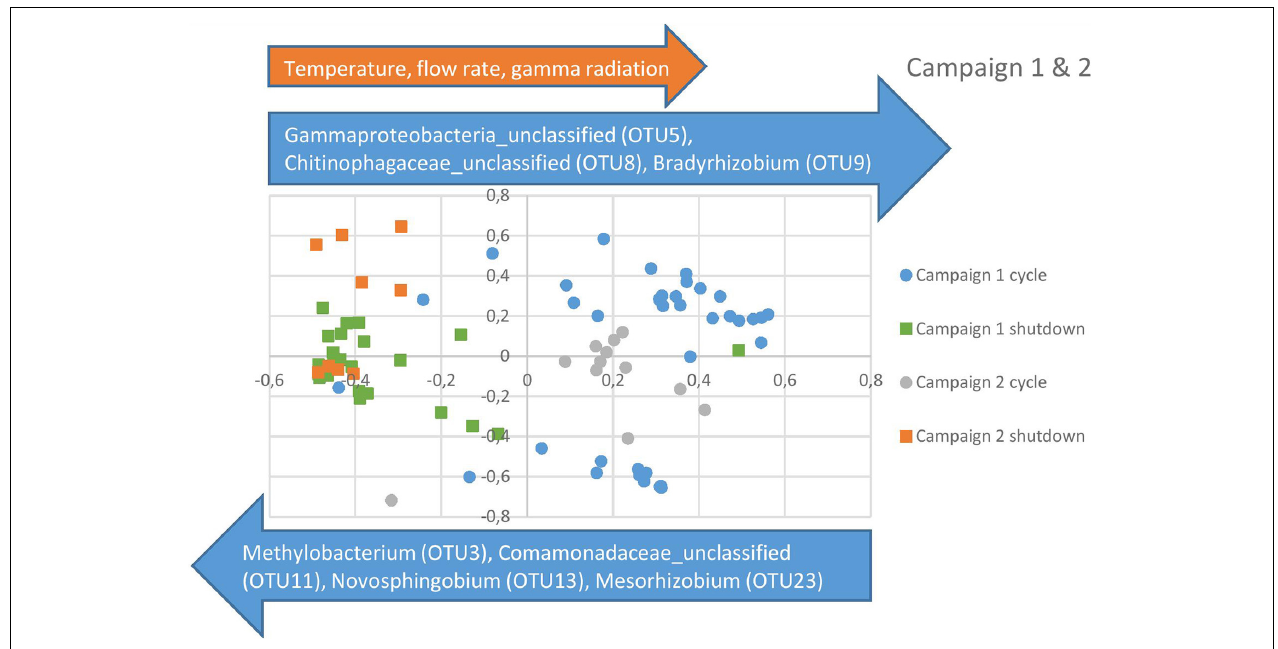
FIGURE 5 | Non-metric Multidimensional Scaling (NMDS) for campaign 1 and 2 combined. The blue and orange arrows, respectively represent the OTUs and physico-chemical parameters showing a significant correlation ( r > 0.6, p < 0.05) with the represented NMDS axes.